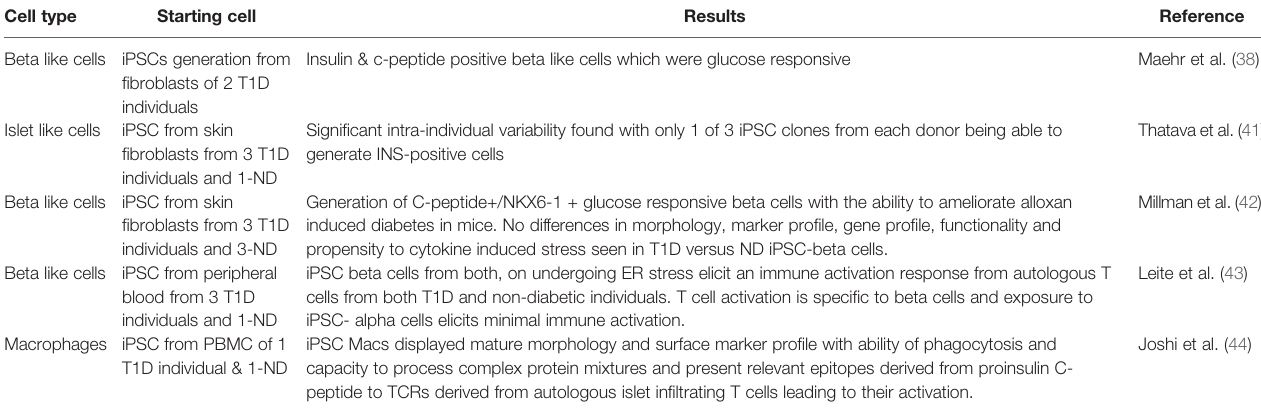
TABLE 1 | Generation of iPSCs and relevant cell types from T1D